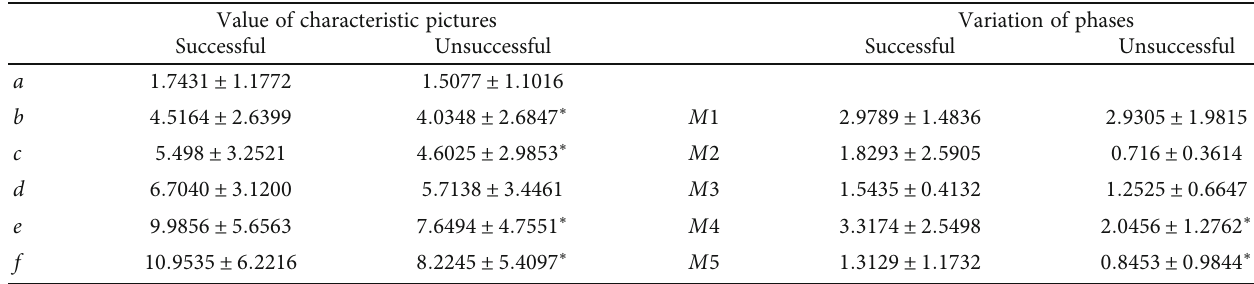
Figure 6: The trajectories of the human and bar combination barycenter of successful and unsuccessful snatch on the Z - axis. Table 5: The displacement of the human and bar combination barycenter at the characteristic pictures and the variation of each phase of successful and failed snatch on the X - axis